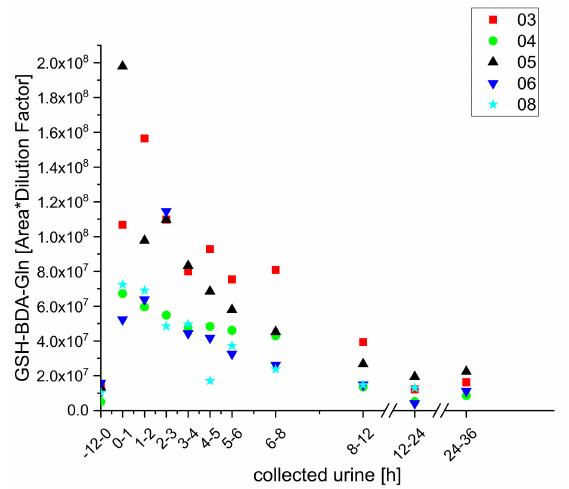
Figure 6. Excretion kinetics of GSH-BDA-Gln: UPLC-qToF-MS / MS measurements of contents in samples of urine from participants three, four, five, six, and eight at indicated times after co ff ee consumption (h). Excretion kinetics of the GSH-conjugate GSH-BDS-Lys from all five subjects were similar: in all cases, levels in the urine samples increased to a maximum within the first hour then continuously decreased until they reached the initial baseline level after 24 h. In contrast, there were clear between-individual di ff erences in excretion kinetics of GSH-BDA-Gln. Levels of this metabolite peaked in urine from subjects four and eight within the first hour, but only after 3 h in urine from subjects five and six. Moreover, it was not detected at all in urine from participant three.